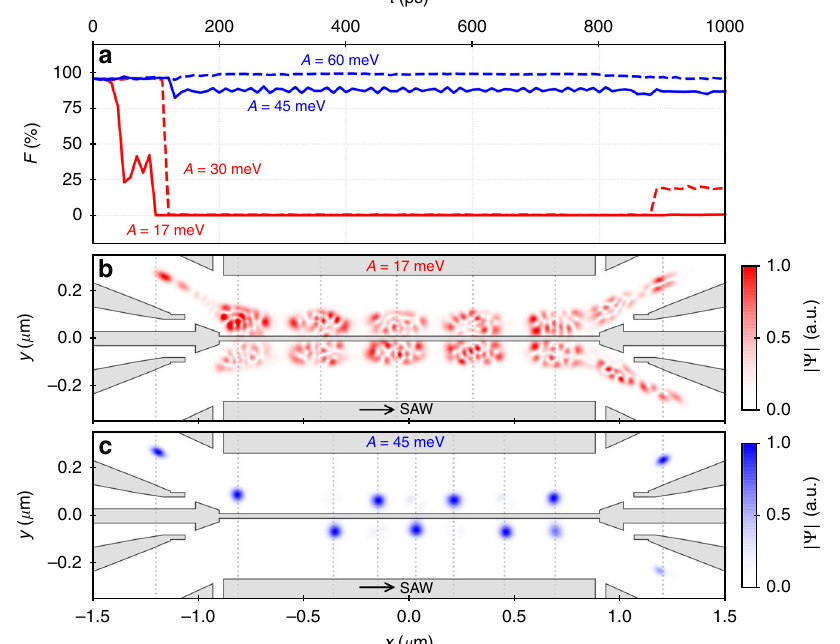
Fig. 3 Time-dependent simulation of electron propagation. a Course of the qubit fi delity, F , for SAW-driven single-electron transport along the coupling region for different values of SAW amplitude, A . b Trace of the electron wave function, Ψ , along the coupled quantum rails for A ¼ 17 meV at selected times, t , indicated via the vertical dashed lines. The grey regions indicate the surface gates. c Trace of Ψ for A ¼ 45